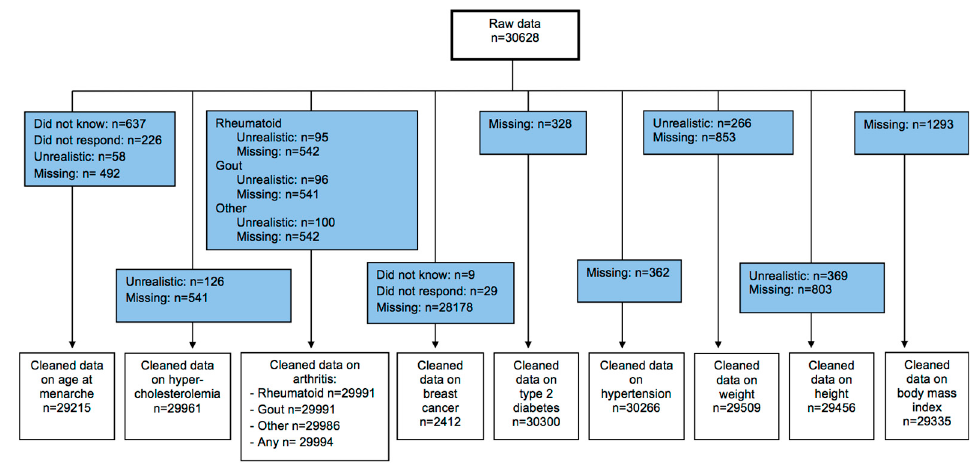
Figure 1. Overview of data cleaning.